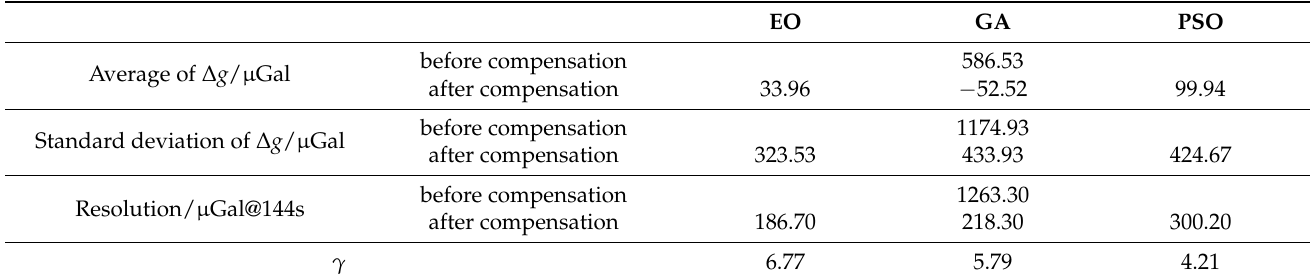
Table 3. Comparison of results from 50 vibration compensations.